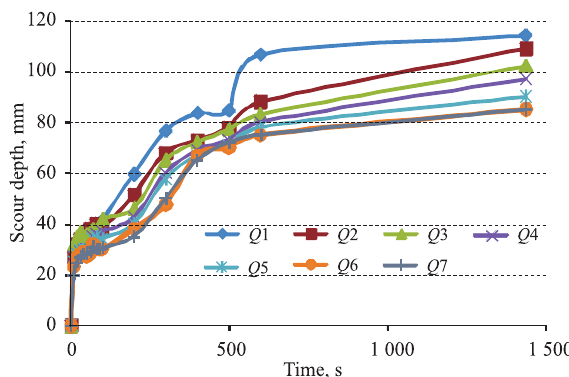
Fig. 11. The effect of fast velocity on the scour depth in Q side with time, vehicle located at quarter-span